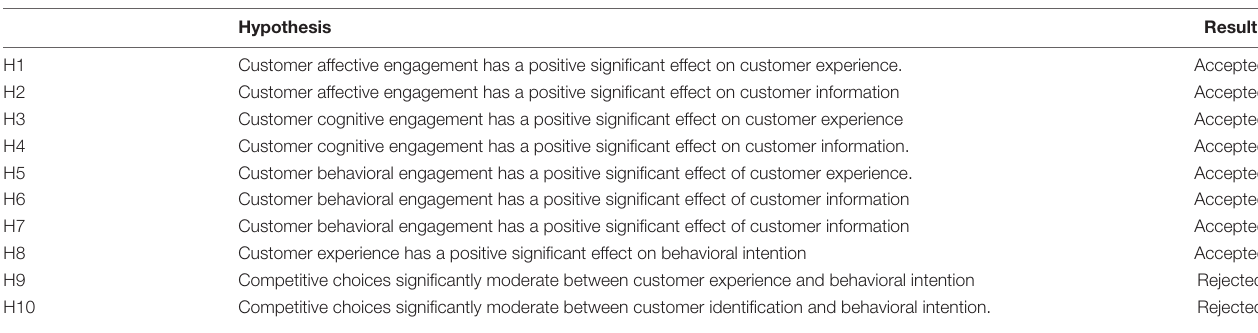
TABLE 6 | Summary of